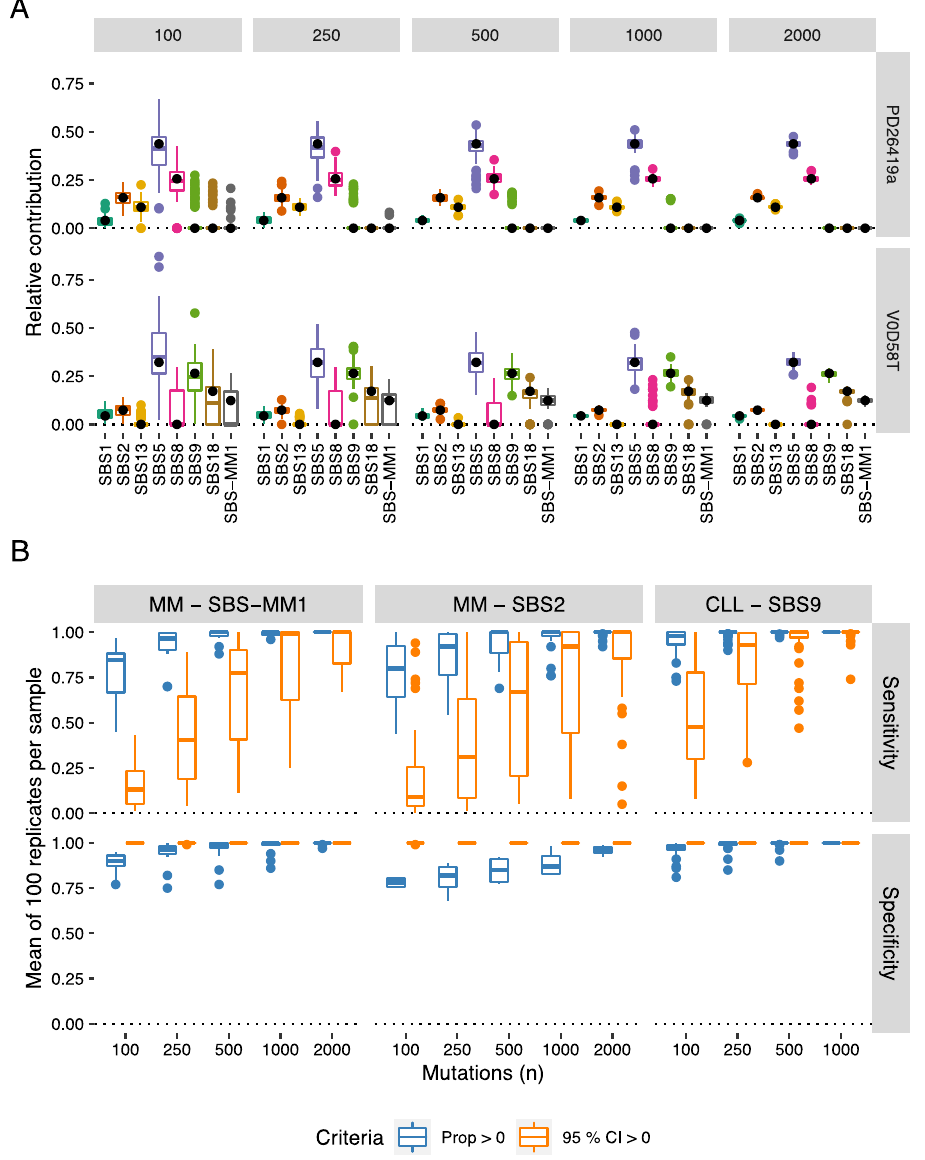
Fig. 7 Mutational signature fi tting with low numbers of mutations. Mutational signature contributions were estimated for each patient in 100 randomly drawn catalogs of 2000, 1000, 500, 250, and 100 mutations. Boxplots show median and interquartile range with outliers drawn as dots. A Mutational signature pro fi les of two example patients (rows), showing the estimated mutational signature contributions (columns). Each data point represents the contribution of a given signature in one randomly drawn mutation set. B Sensitivity and speci fi city of mmsig to identify SBS-MM1 in MM (left), SBS2 in MM (middle) and SBS9 in CLL (right) when different criteria were applied (color legend). Each data point represents the mean estimated sensitivity or speci fi city across 100 replicates for a given patient and mutation